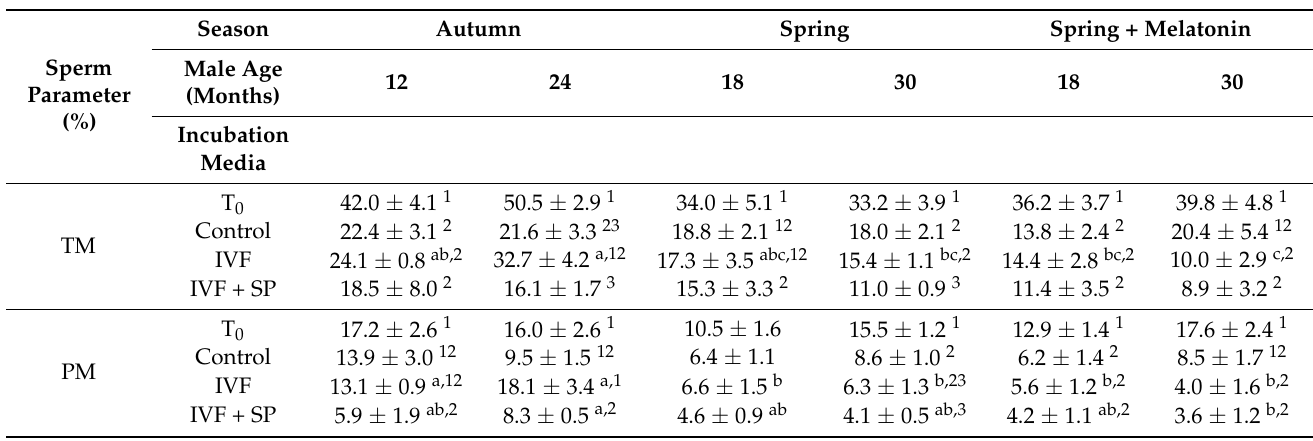
Table 3. Effect of seminal plasma and its resilience under in vitro capacitation conditions on the total and progressive motility of thawed buck sperm with respect to male age (months) season, and melatonin implant.